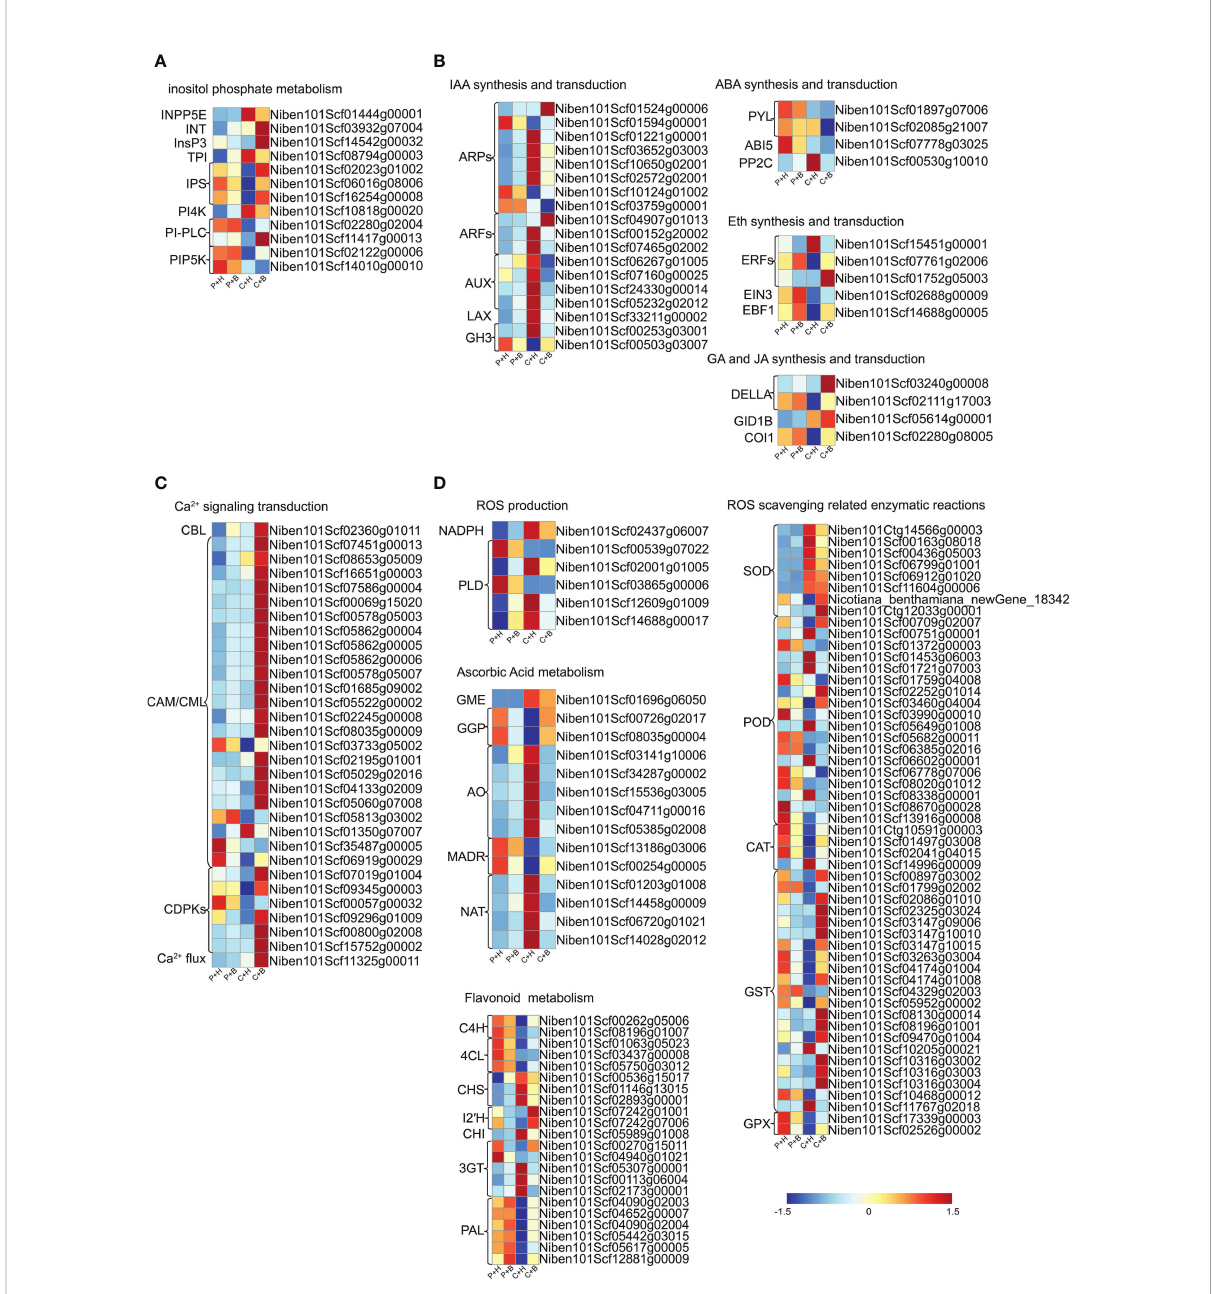
FIGURE 5 Heat map of the expression levels of DEGs involved in different pathways in N. benthamiana . (A) DEGs in inositol phosphate metabolism. (B) DEGs in phytohormones. (C) DEGs in Ca 2+ signaling transduction. (D) DEGs in ROS metabolism. P+H, PBS solution + H 2 O; P+B, PBS, PBS solution + boron; C+H, CGMMV + H 2 O; C+B, CGMMV +